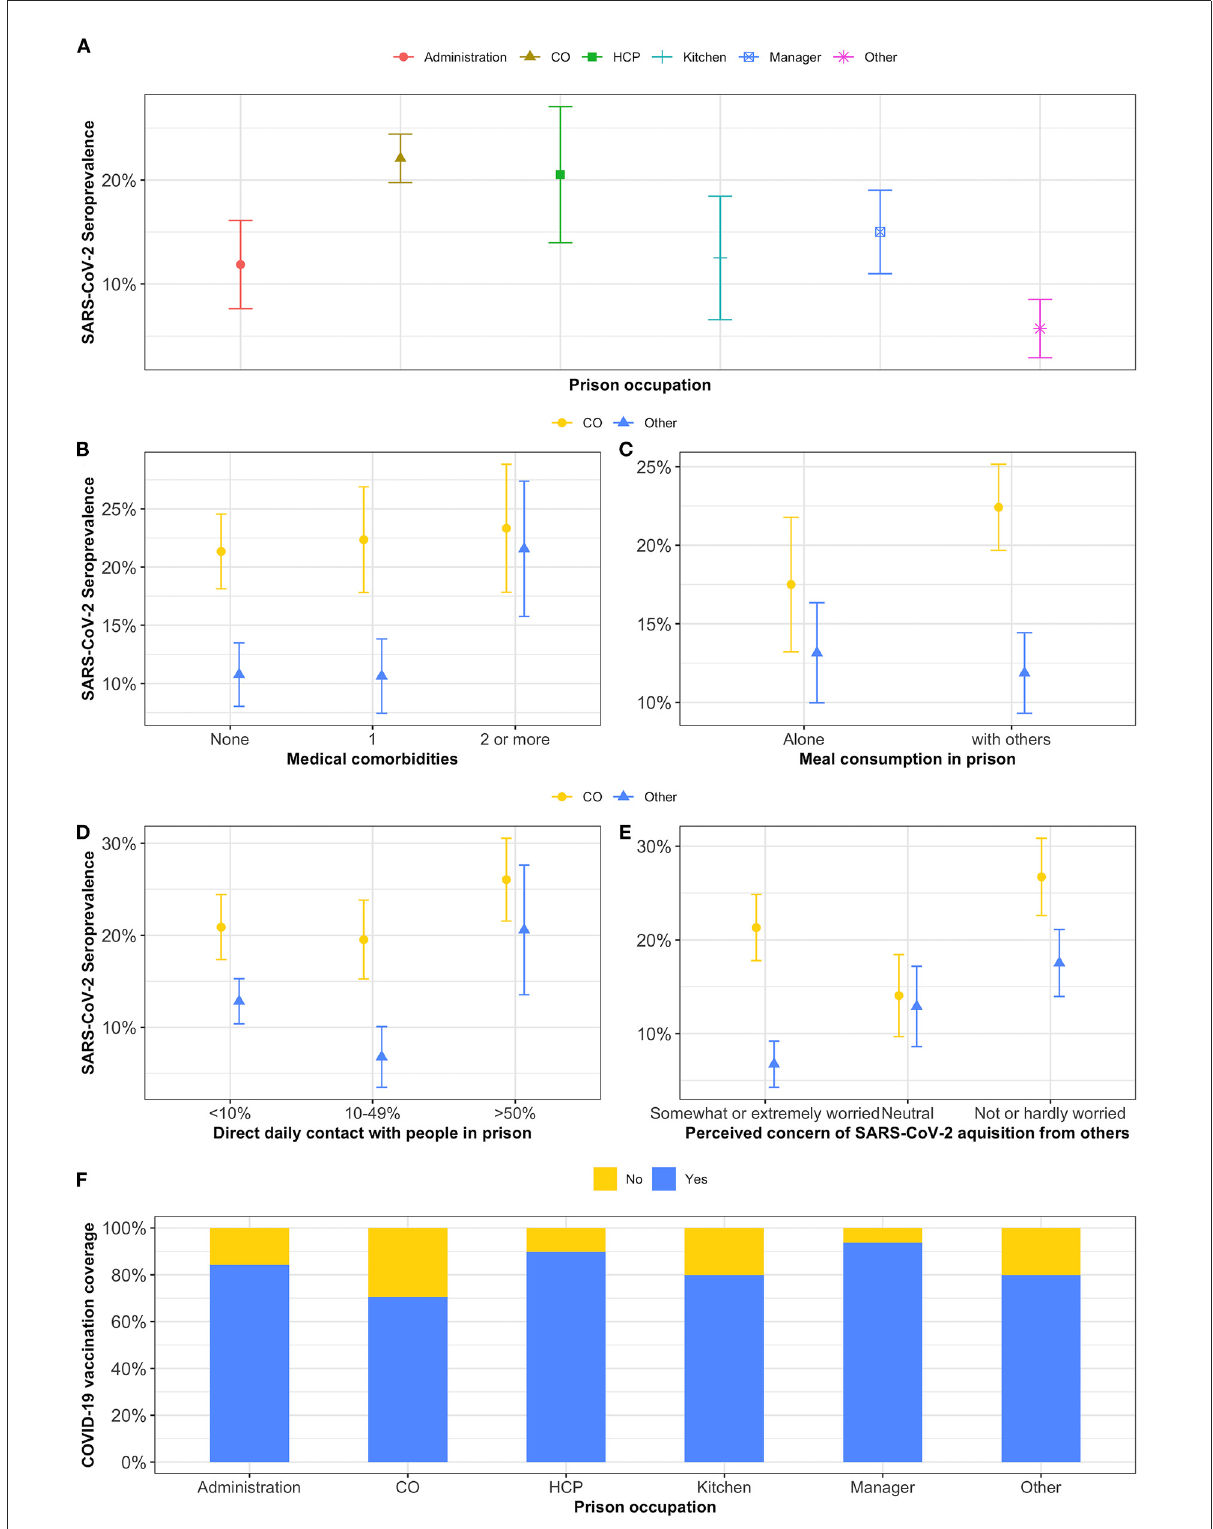
FIGURE1 (A–F) Point prevalence of SARS-CoV-2 and COVID-19 vaccination coverage by prison occupation. CO, correctional officers; HCP, healthcare providers; Other, other occupations (i.e., probation agents, community workers, janitorial staff, building maintenance, teachers, pastoral, laundry, library, researchers, information technology, and